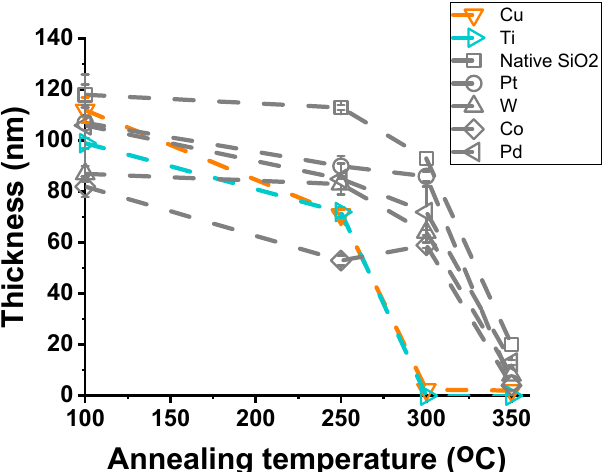
Figure 5. Thicknesses of PMMA films remaining on different surfaces after annealing for 30 min under H 2 . Curves for the most catalytic surfaces (Cu and Ti) are shown in colours, while those for inactive surfaces and surfaces comparable to SiO 2 are in grey.